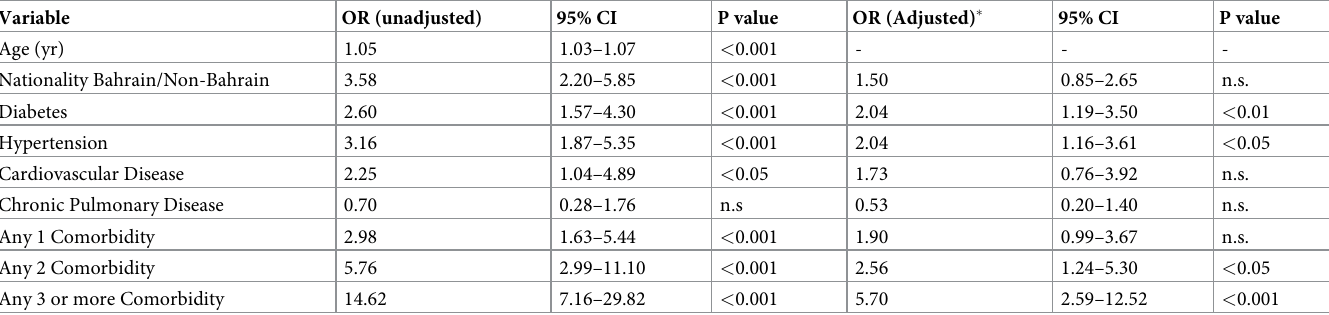
� Adjusted for age.